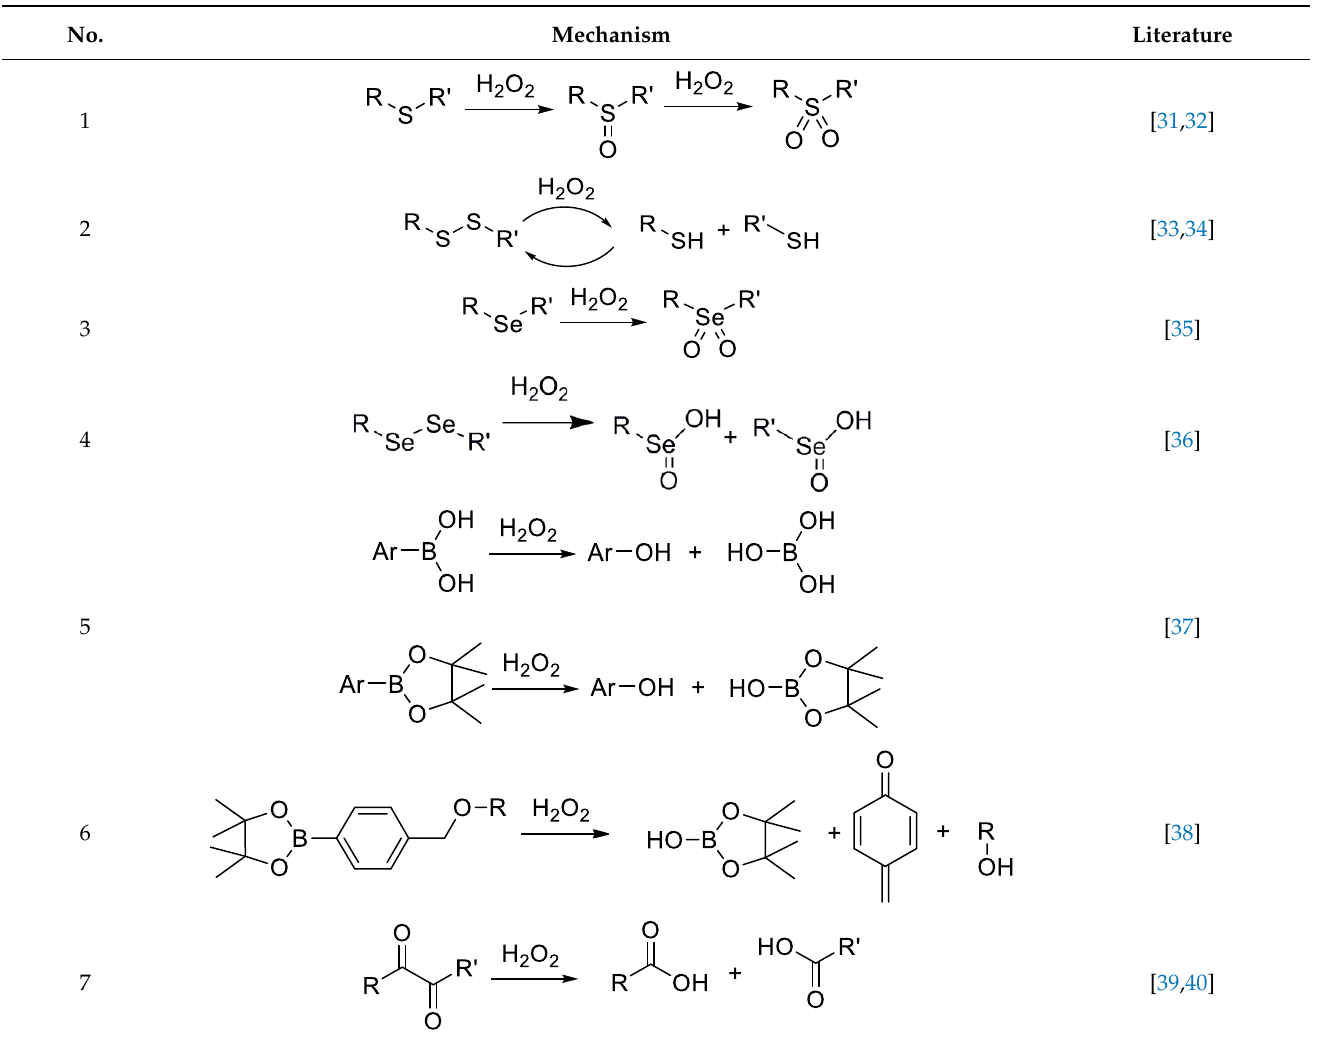
Table 1. Summary of responsive mechanism to H 2 O 2.